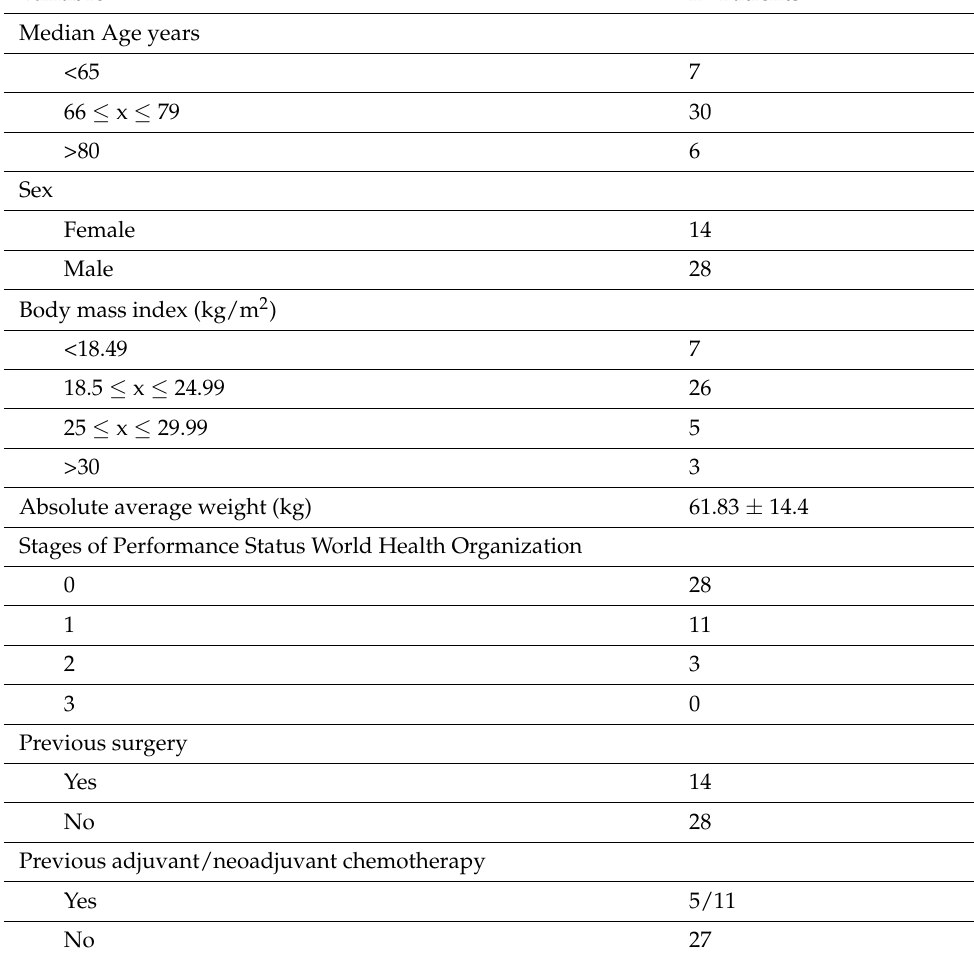
Table 1. Patient demographics and clinical characteristics.